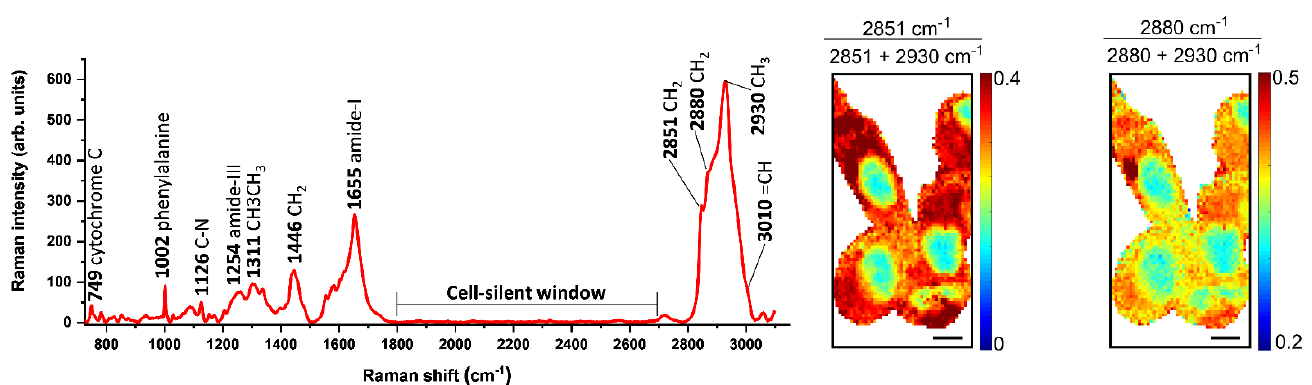
Figure 2. Raman spectroscopy of PC-3 cells. The Raman spectrum was acquired from a live PC-3 cell using a 532 nm laser excitation source, which was focused onto the sample using a 60 × objective lens (18 mW) for 10 s. Ratiometric Raman mapping of live PC-3 cells using the same acquisition settings except spectra were acquired for 0.5 s per pixel, with a 1 µ m pixel size for imaging. The images present the lipid/protein ratios using the following Raman bands: 2851 cm − 1 (CH 2 symmetric stretch, lipids), 2880 cm − 1 (CH 2 asymmetric stretch, lipids and proteins) and 2930 cm − 1 (CH 3 symmetric stretch, proteins), based on formulae accompanying each panel. Nuclear regions are identified with a lower ratio than the surrounding cytoplasm, which is lipid-rich. Scale bars: 10 µ m.